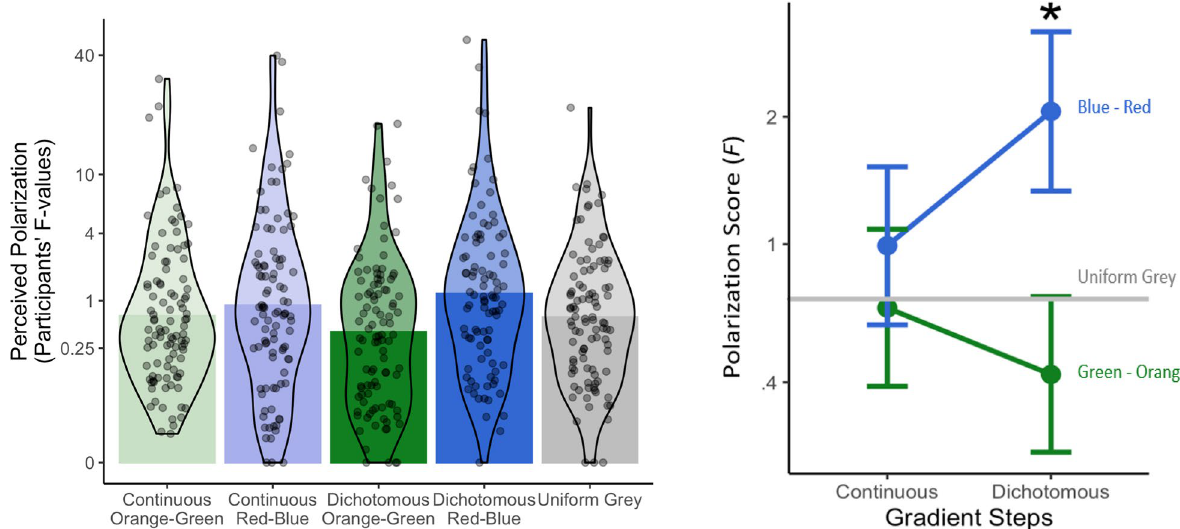
Fig. 4 Polarization of judgments (participant-level F-values) in the Polarization Task across the five between-subject conditions are presented on the left. Estimates from Model 2 are presented on the right. The interaction between Gradient Steps and Hue Pair was significant, as was the simple effect of Hue Pair for Dichotomous maps. Note that the F-values depicted in these plots are untransformed for ease of interpretability but were raised to the ¼ power for the analyses to correct for positive